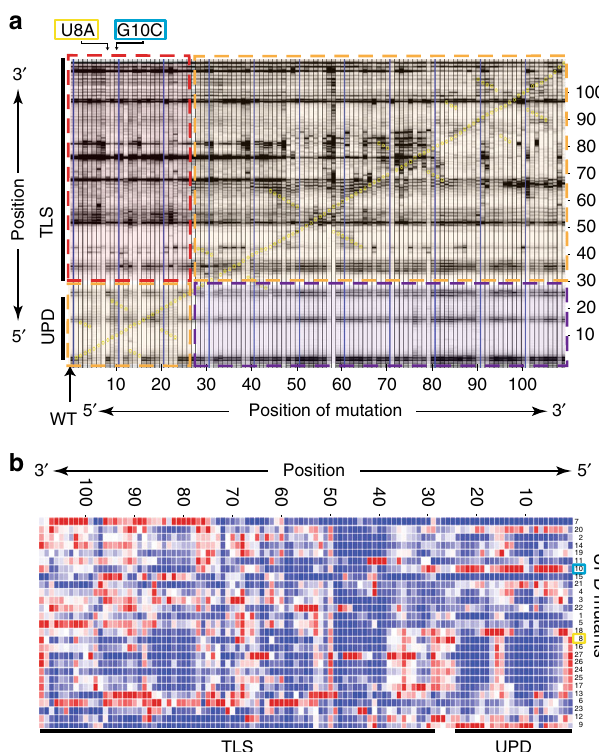
Fig. 3 Structural coupling between RNA domains. a MCM with NMIA. X -axis: mutation position. Y -axis: sequence position. Domains indicated. Orange: modi fi cation patterns in a domain due to mutations within the same domain. Red and magenta: changes in one domain due to mutations in the other domain. b Hierarchical clustering of the difference of each mutant from the wild-type RNA (Supplementary Fig. 4). Blue: less reactive. Red: more reactive. Yellow and cyan: mutants U8A and G10C,